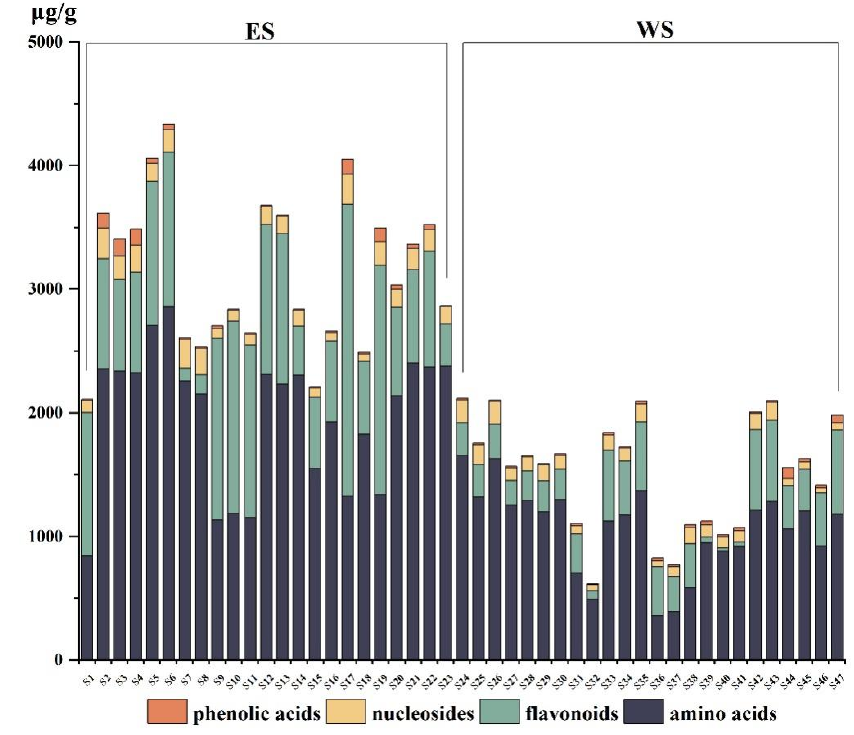
Figure 3. The contents of four kinds of chemical constituents in ES and WS.